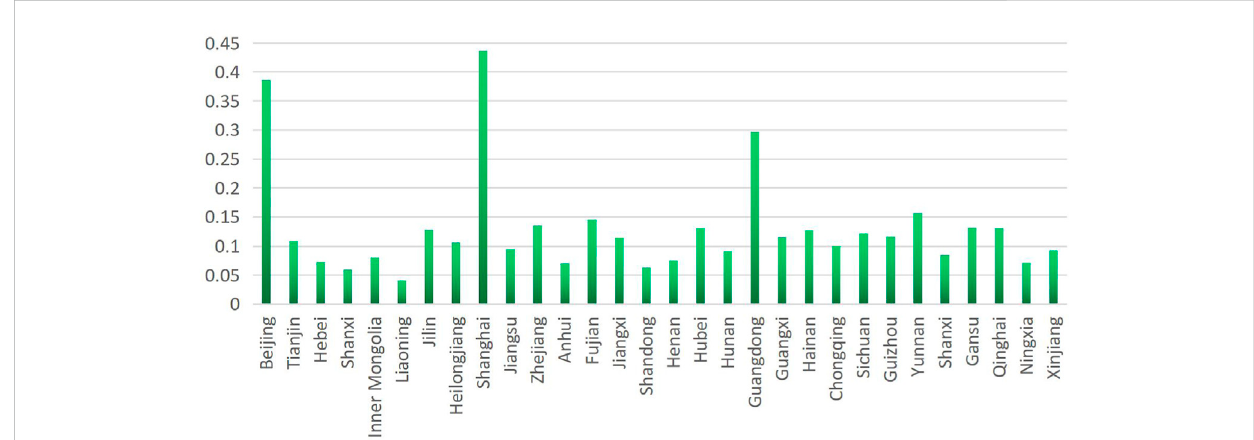
FIGURE 3 Thecomprehensivescoresofhigh-qualitygreenenergydevelopmentinChinain2018.Datasource:TheauthorusesthedataofChinafrom2010to 2018 to calculate the level of high-quality green energy development in different regions by entropy weight method. Note:The author uses the of fi ce software excel (one of the Of fi ce components in the Of fi ce software package developed by Microsoft in United States) to